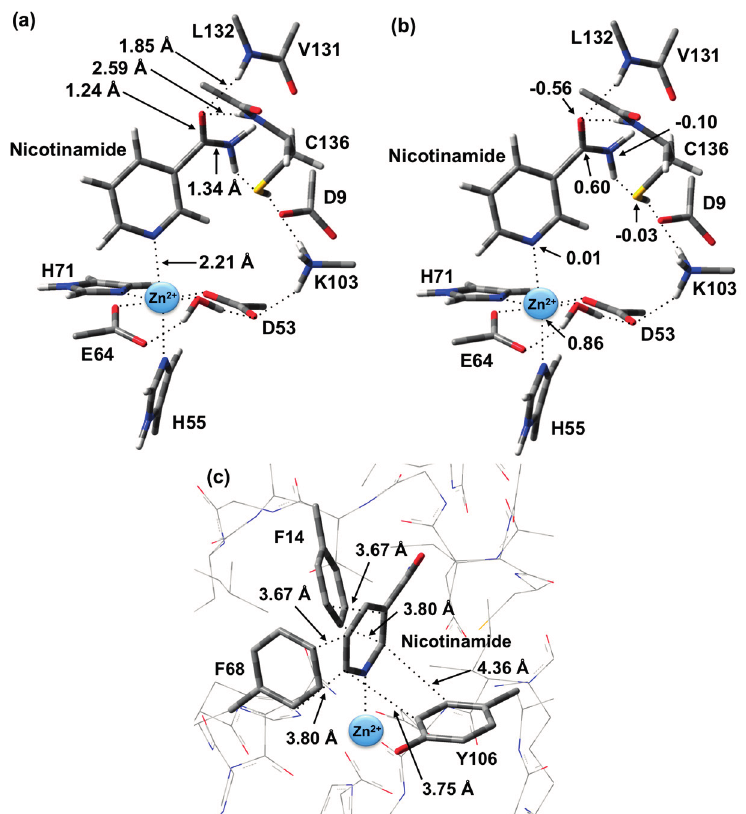
Figure 1. Optimized structure with ( a ) selected distances shown (Angstroms), ( b ) ESP charges, and ( c ) π -interactions in the substrate-bound active site, reactant complex ( RC ), obtained at the ONIOM(B3LYP/6-31G(d):AMBER96)-ME level of